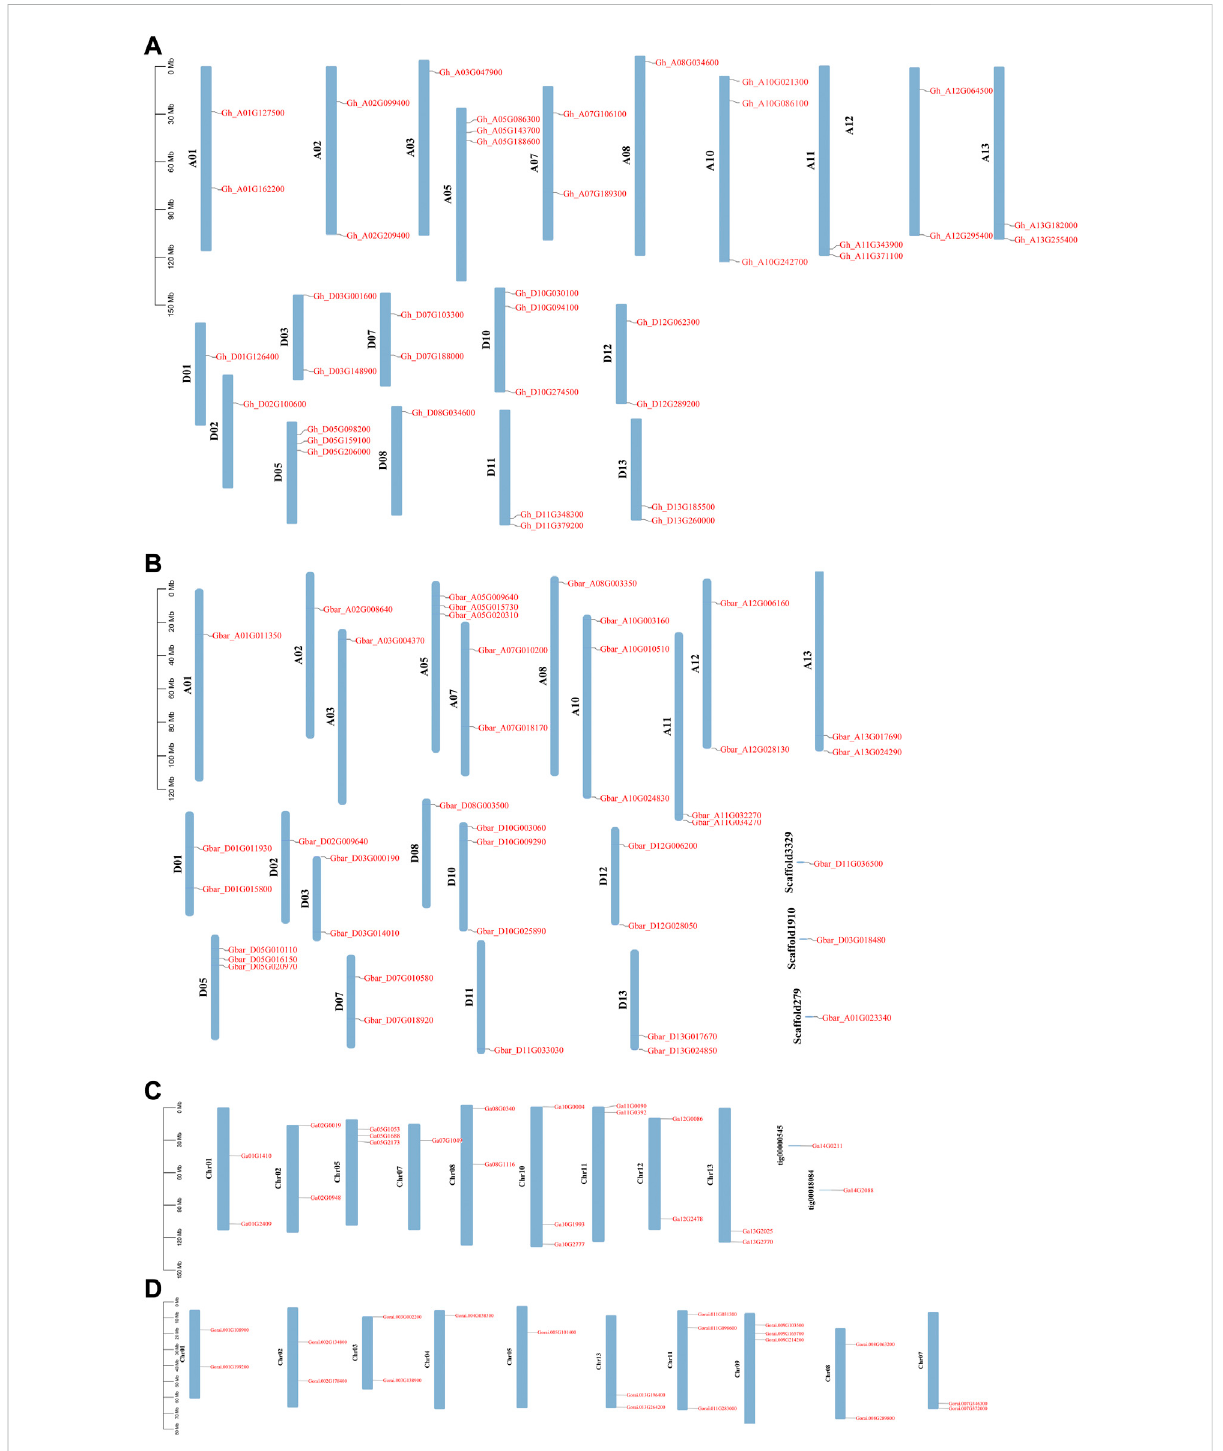
FIGURE 1 WOX genes position on the chromosome in Gossypium species. (A) G. hirsutum , (B) G. barbadense , (C) G. arboreum , and (D) G. raimondii